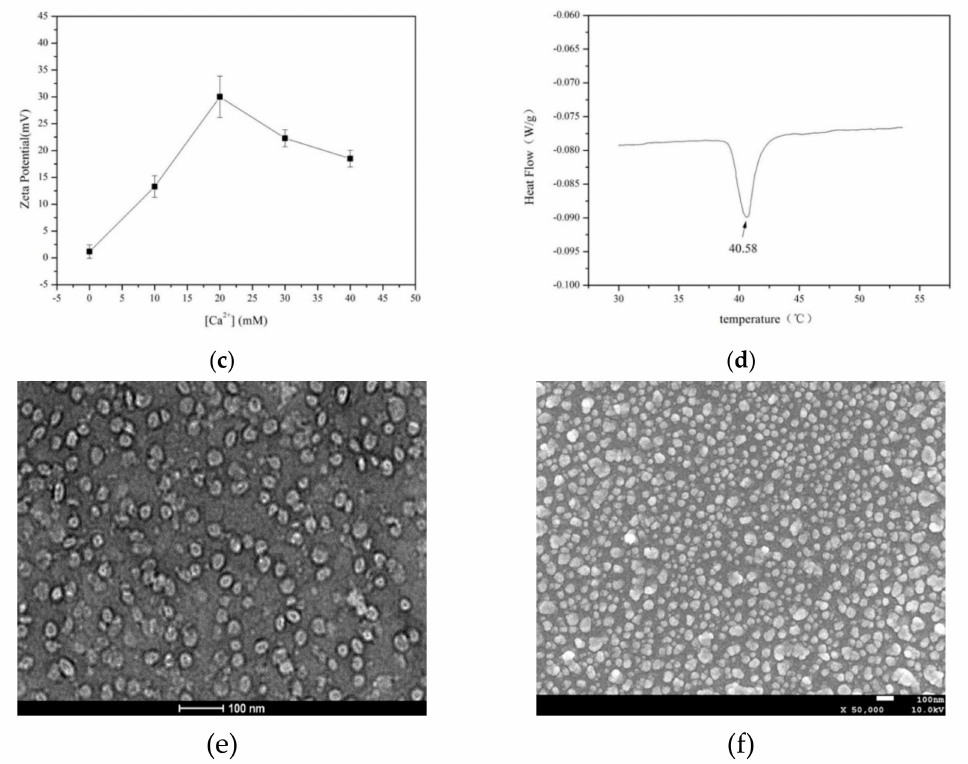
Figure 1. Characterization of the thermosensitive phospholipid microcapsules. Particle size and distribution ( a ), Tm of di ff erent dipalmitoylphosphatidylcholine (DPPC):phosphatidic serine (PS):Brij78 molar ratio ( b ), zeta potential at di ff erent concentrations of Ca 2 + ( c ), phase transition temperature (Tm) under the concentration of 20 mM Ca 2 + ( d ), TEM image ( e ), and SEM image ( f ) of the thermosensitive phospholipid